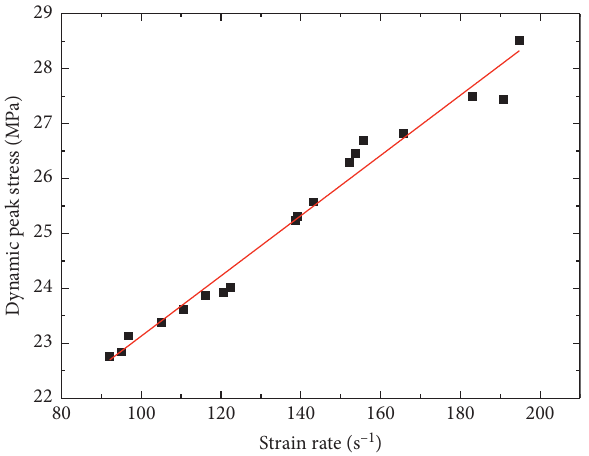
Figure 6: Dynamic peak stress-strain rate.